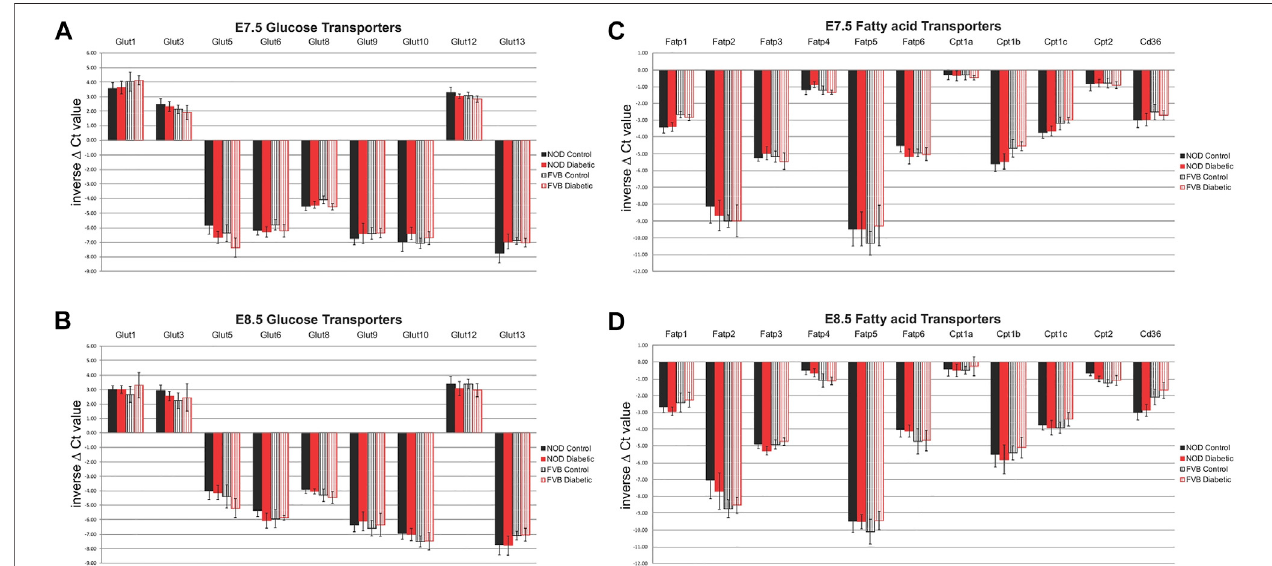
FIGURE3| ValidationofRNAscopeprobesforGlucosetransporters.TargetcDNAsinlinearizedformwerespottedontoaglassslideasshownintheschematicin Panel (A) . Panel (B) : RNAscope probes were hybridized to all spots in a given column; probe binding (red signal) was only observed at the spot containing the cognate cDNA.Panel (C) :ImageoftheresultinPanel (B) ,whichrevealsthesignalasred fl uorescence.Nocross-reactivitieswereobserved,demonstratingexclusivespeci fi cityof each RNAscope probe for its target.